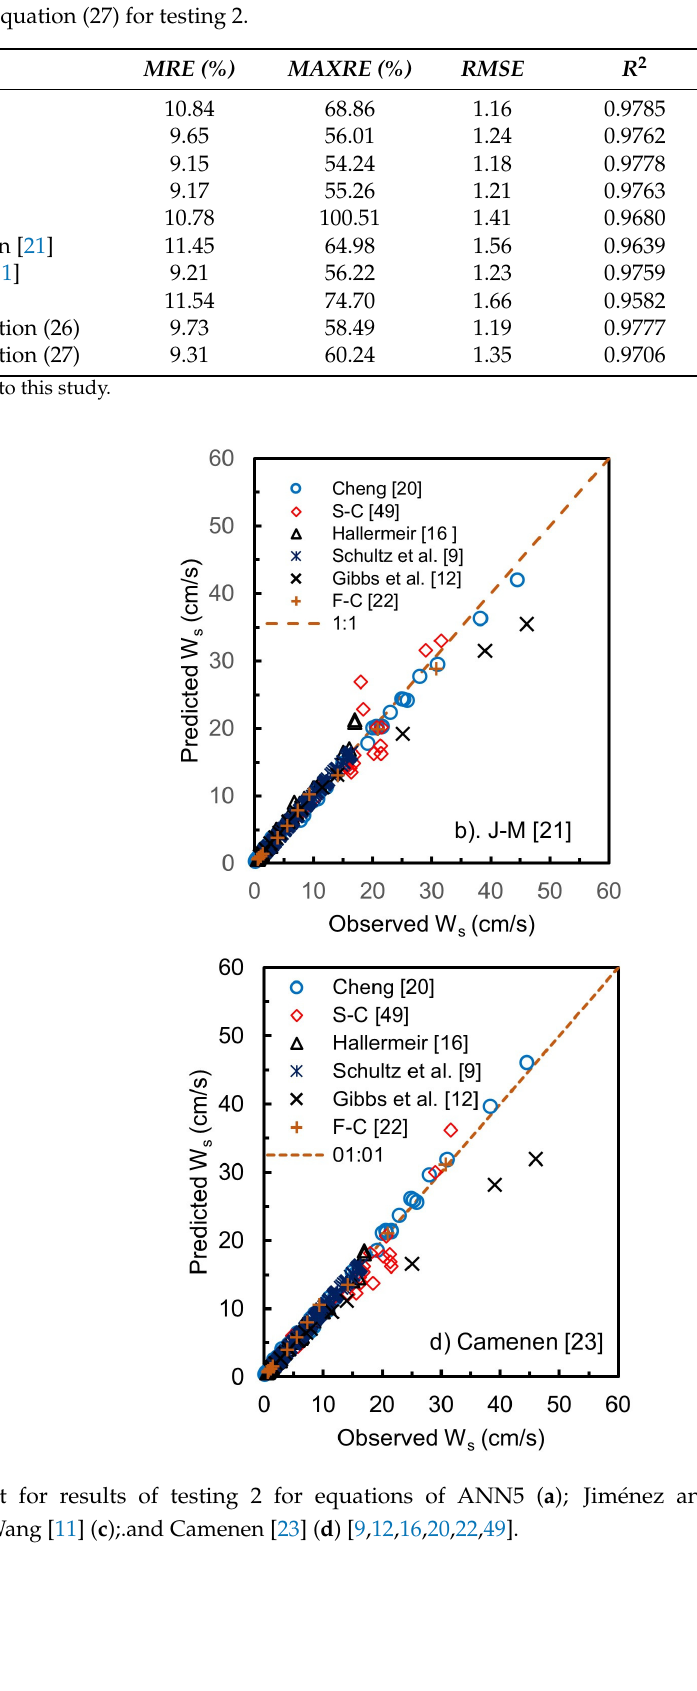
Figure 10. Scattering plot for results of testing 2 for simplified ANN4 Equation (26) ( a ) and simpli- fied ANN5 Equation (27) ( b ).